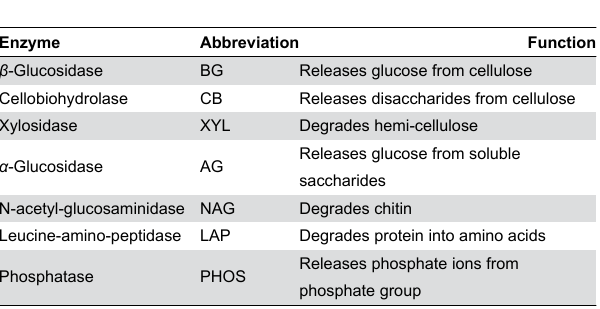
Table 1. List of enzymes assayed in this